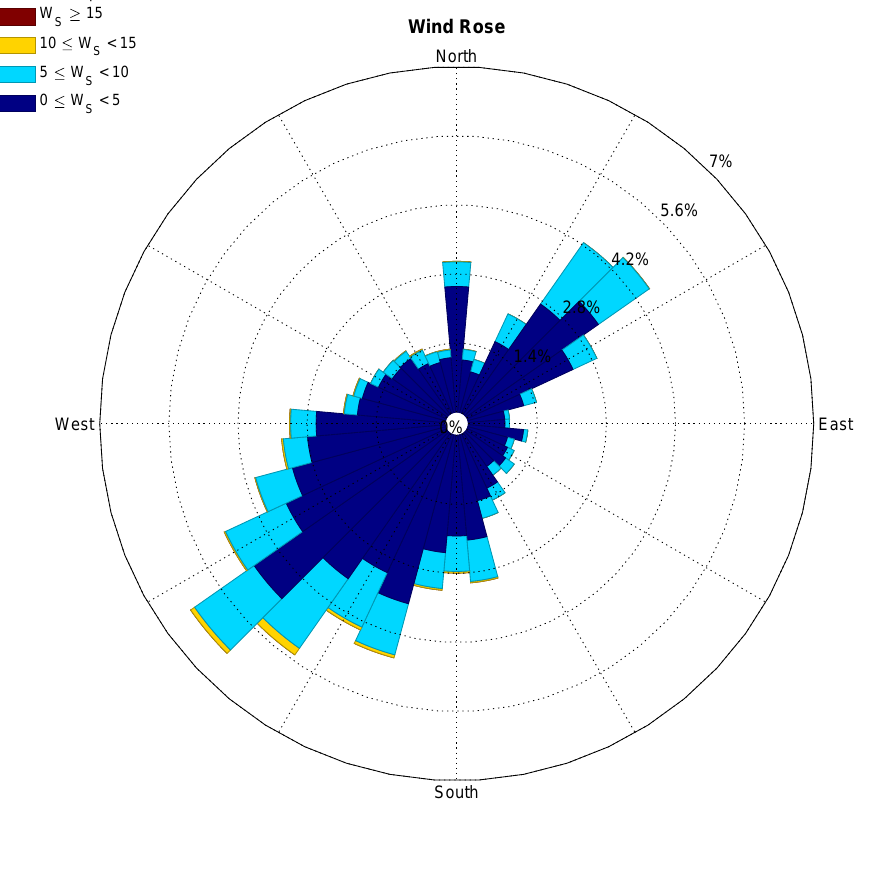
Figure 10. Rose portrait of WD (North = 0) and speed (m/s) in off-shore wind farms (OSWFs) in Yangshan port, Shanghai from 22 August 2017 to 22 August